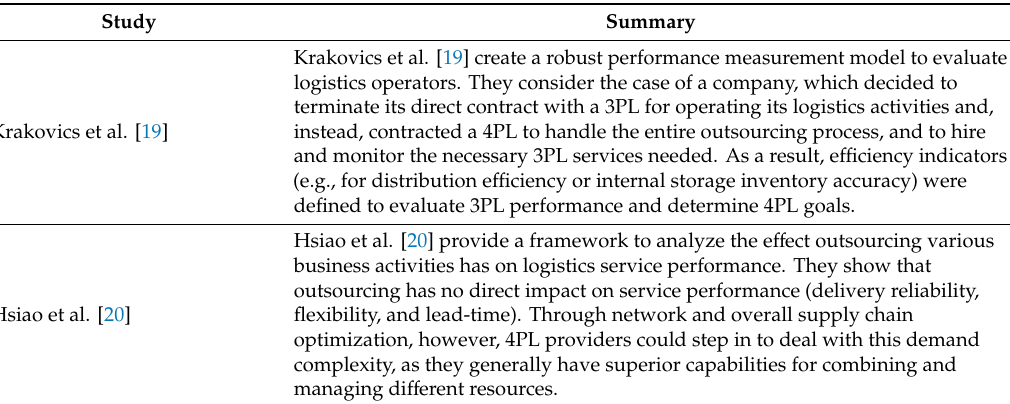
Table 2. Selected papers on fourth-party logistics